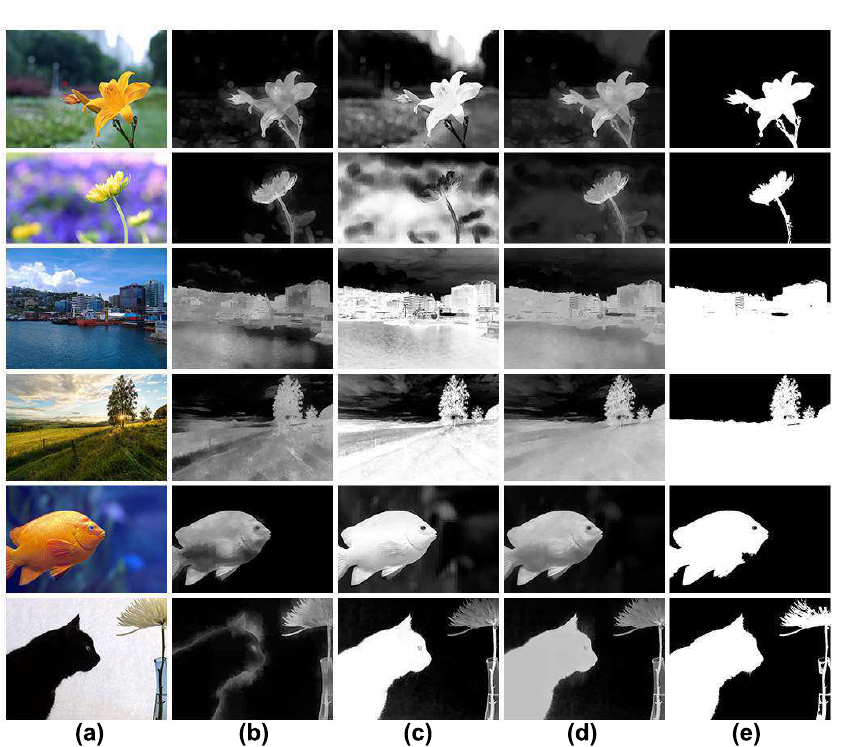
Figure 7. ROI map computation process. ( a ) original images, ( b ) sharpness maps, ( c ) color saliency maps, ( d ) ROI maps. ( e ) binarized ROI